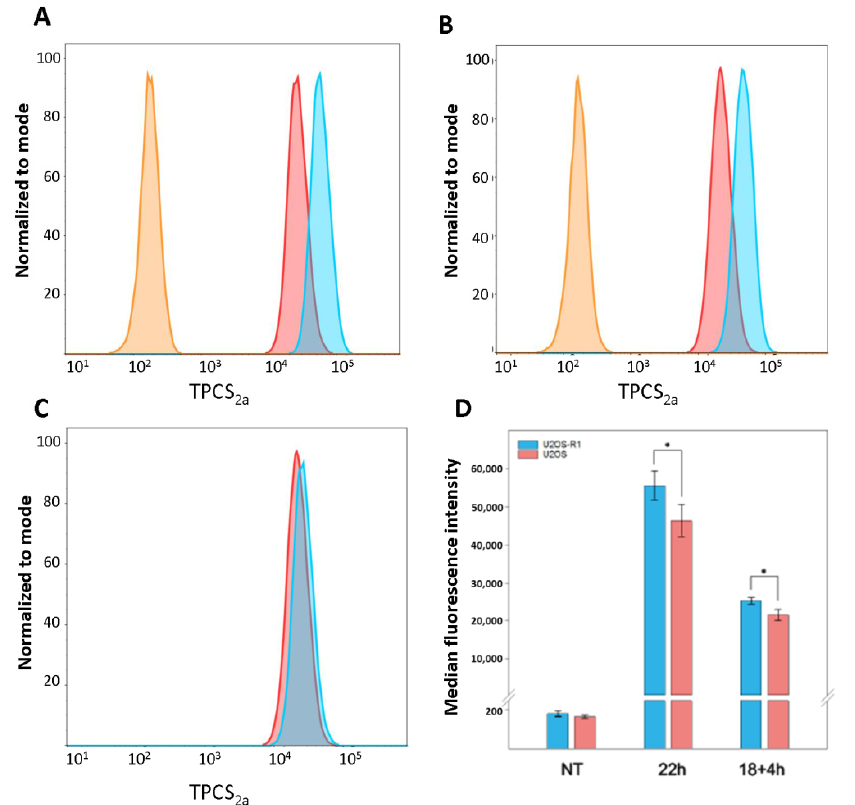
Figure 2. Cellular uptake of TPCS2a evaluated by flow cytometry. ( A – C ) Representative histograms from one experiment, ( D ) median fluorescence intensity (MFI) as an average from three independent experiments. Cells were incubated with 0.2 µ g/mL TPCS2a for 22 h or 18 + 4 h (2 × wash after 18 h). ( A , B ) U2OS-R1 and U2OS cells, respectively. Orange histograms represent untreated cells. Treated cells are shown in red (18 + 4 h) and blue (22 h). ( C ) U2OS (red) and U2OS-R1 (blue) when treated for 18 + 4 h from ( A , B ). ( D ) Average MFI determined on the basis of three independent experiments. Error bars ± S.D. * p < 0.05 (two-tailed Student’s t -test). Blue bars represent U2OS-R1 cells, red bars represent U2OS cells.